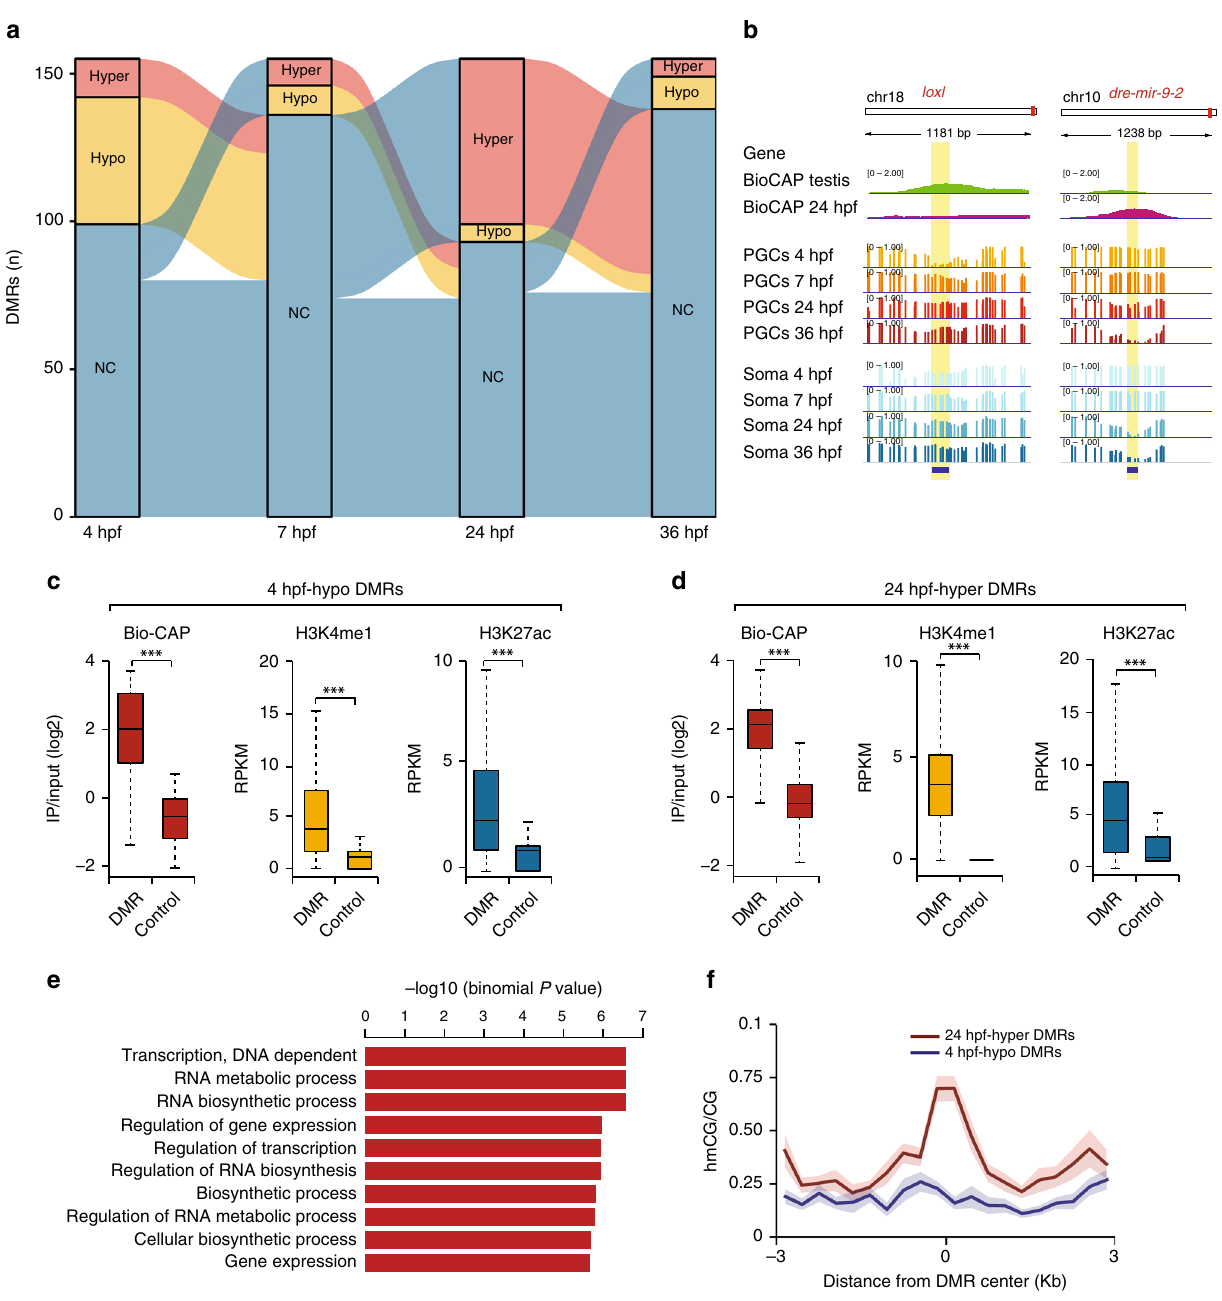
Fig. 3 Locus-speci fi c 5-methylcytosine (5mC) changes in primordial germ cells (PGCs). a Alluvial plot showing the number of hypo- and hypermethylated differentially methylated regions (DMRs) in PGCs compared to somatic cells and their dynamics across four developmental stages. b Browser track depicting DNA methylome pro fi les of 4 hpf-hypo and 24 hpf-hyper DMRs in PGCs and soma at four developmental stages as well as CpG island (Bio-CAP) signal in testis tissue and 24 hpf embryos. c , d Boxplots showing BioCAP, H3K4me1, and H3K27ac chromatin immunoprecipitation-sequencing (ChIP-seq) signal enrichment at 4 hpf-hypo ( c ) and 24 hpf-hyper ( d ) DMRs compared to a set of size distribution-matched control regions ( p value <0.001, Student ’ s t test). The boxes show the interquartile range (IQR) around the median. The upper and lower whiskers extend from the hinge to the largest and smallest value, respectively, no further than 1.5 IQR. e Gene ontology (GO) analysis of genes located in the vicinity of 24 hpf-hyper DMRs. f Tet-assisted bisul fi te sequencing (TAB-seq) (5-hydroxymethylcytosine (5hmC) — from 24 hpf whole embryos) enrichment pro fi les over 4 hpf-hypo and 24 hpf-hyper DMRs extended 3 kb up- and downstream from the DMR centre, displaying signi fi cant ( p value = 1.819e − 12, Wilcoxon ’ s signed-rank test) differences. 5hmC values were calculated in 300 bp